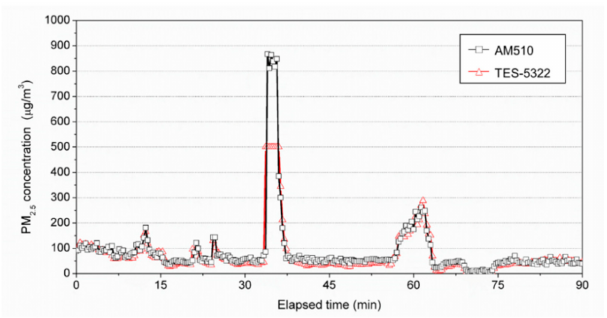
Figure 7. Comparison of the PM 2.5 concentration measurement results of AM510 and TES-5322 after